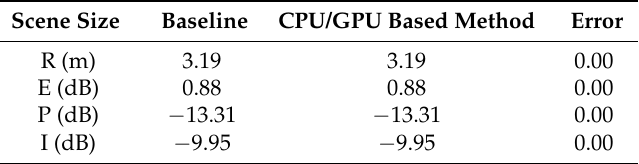
Table 7. Imaging indicators of range